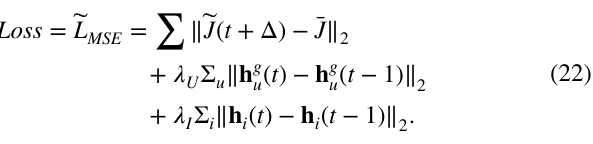
Table 4 The ablation study results of the resource constraint branch RecNetDatasets